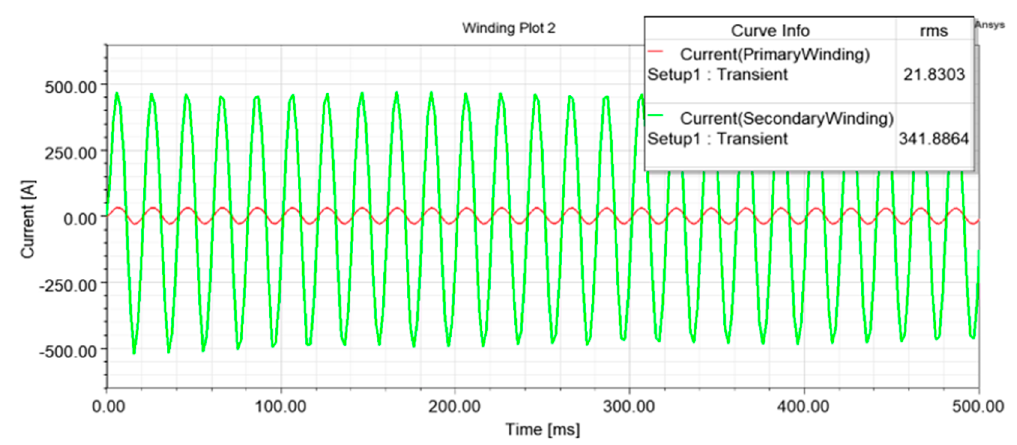
Figure 10. The RMS values of the BSST primary (red line) and secondary (green line) copper windings currents.